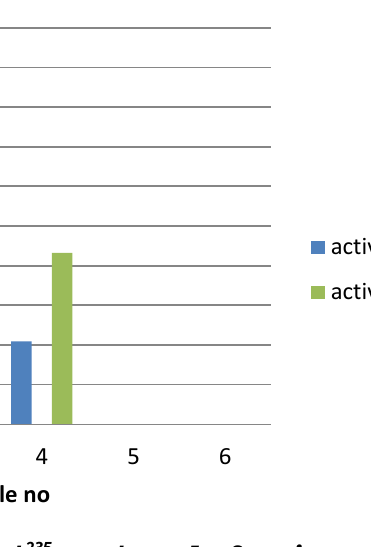
Fig. 5: Activates for 238 U and 235 U and samples for rain